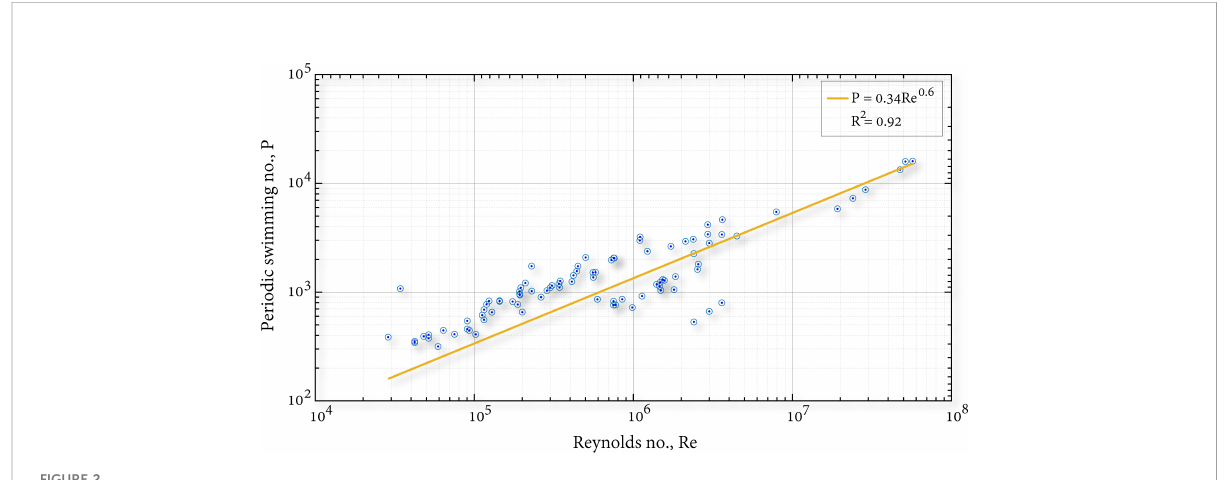
FIGURE 2 Periodic swimming number vs. Reynolds